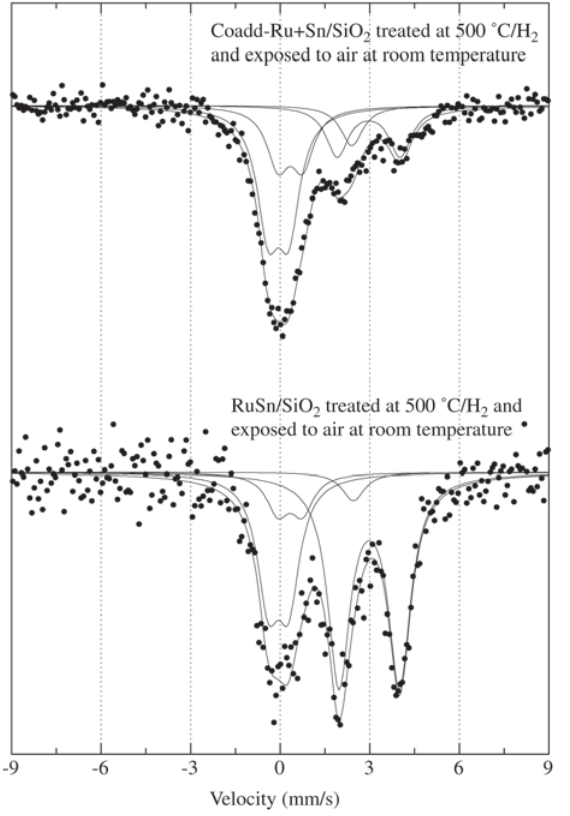
Figure 3. 119 Sn Mössbauer spectra obtained at 23 K for the sol-gel SiO supported RuSn catalysts submitted to different treatments. 2